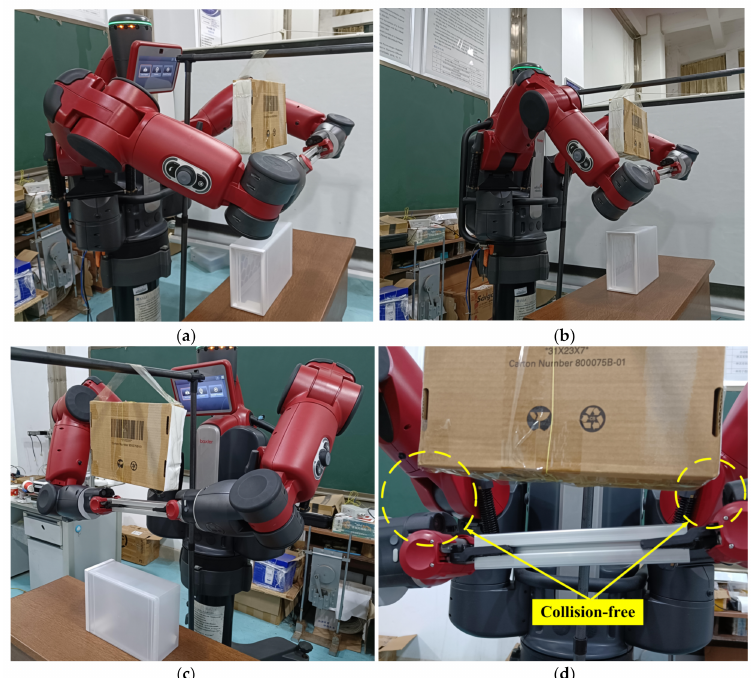
Figure 6. Actual motion process: ( a ) connection node of the tree T 1 ; ( b ) connection node of the tree T 2 ; ( c ) global view of a node located between two obstacles; ( d ) partial enlarged view of a node located between two